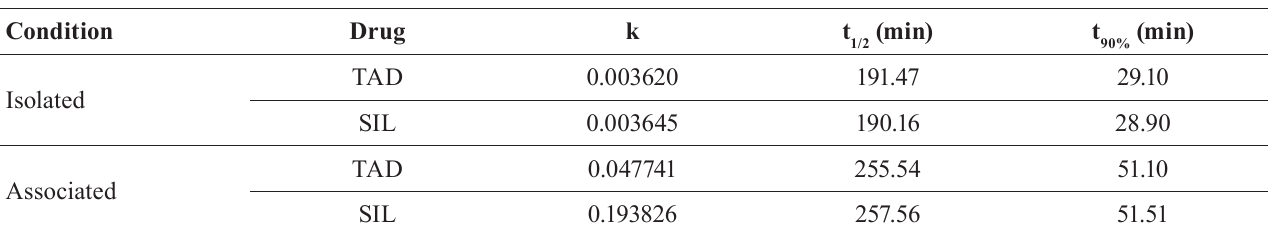
TABLE V - P hotodegradation kinetics parameters of the drugs